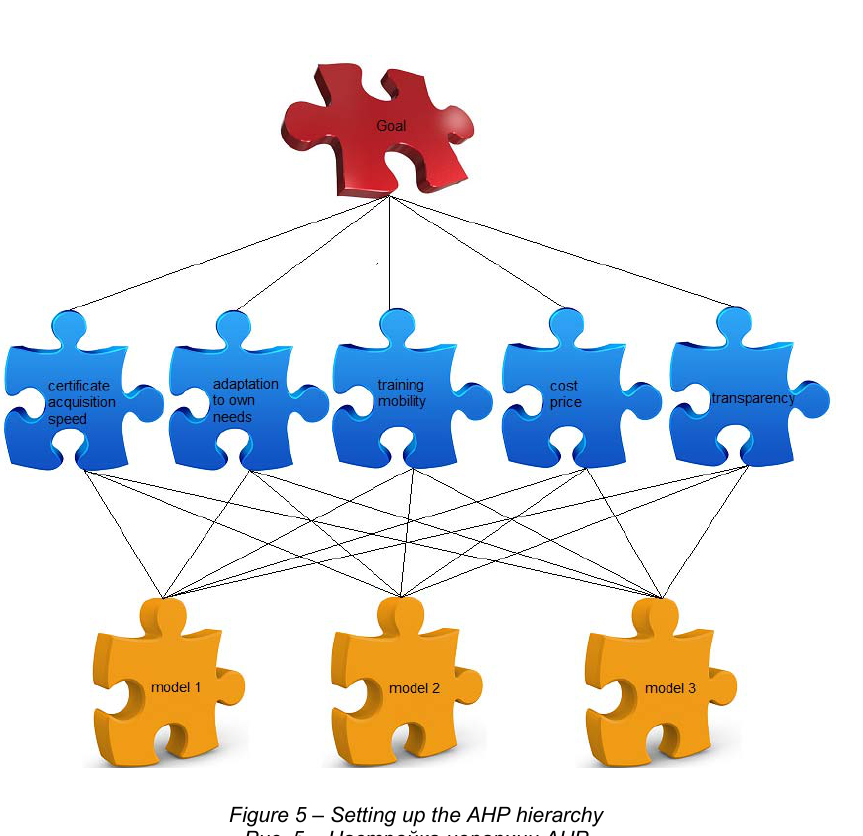
Figure 5 – Setting up the AHP hierarchy Pu с . 5 – Настройка иерархии